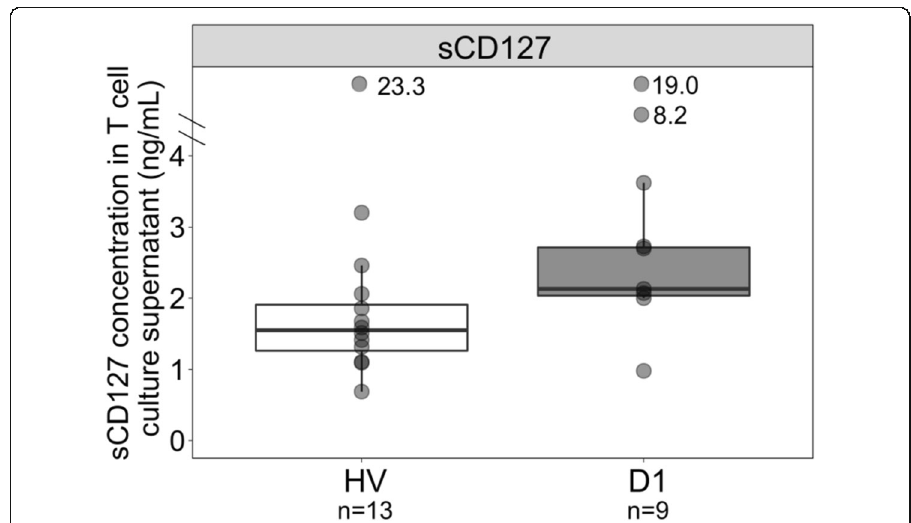
Fig. 1 sCD127 protein release from purified T cells from septic shock patients. sCD127 release was quantified in supernatants of purified T cells of septic shock patients (D1, n = 9) in comparison with healthy volunteers (HV, n = 13) after 48 h of culture without any stimulation. Data are presented as Tukey boxplots. Mann-Whitney tests were used to compare values between septic shock patients and